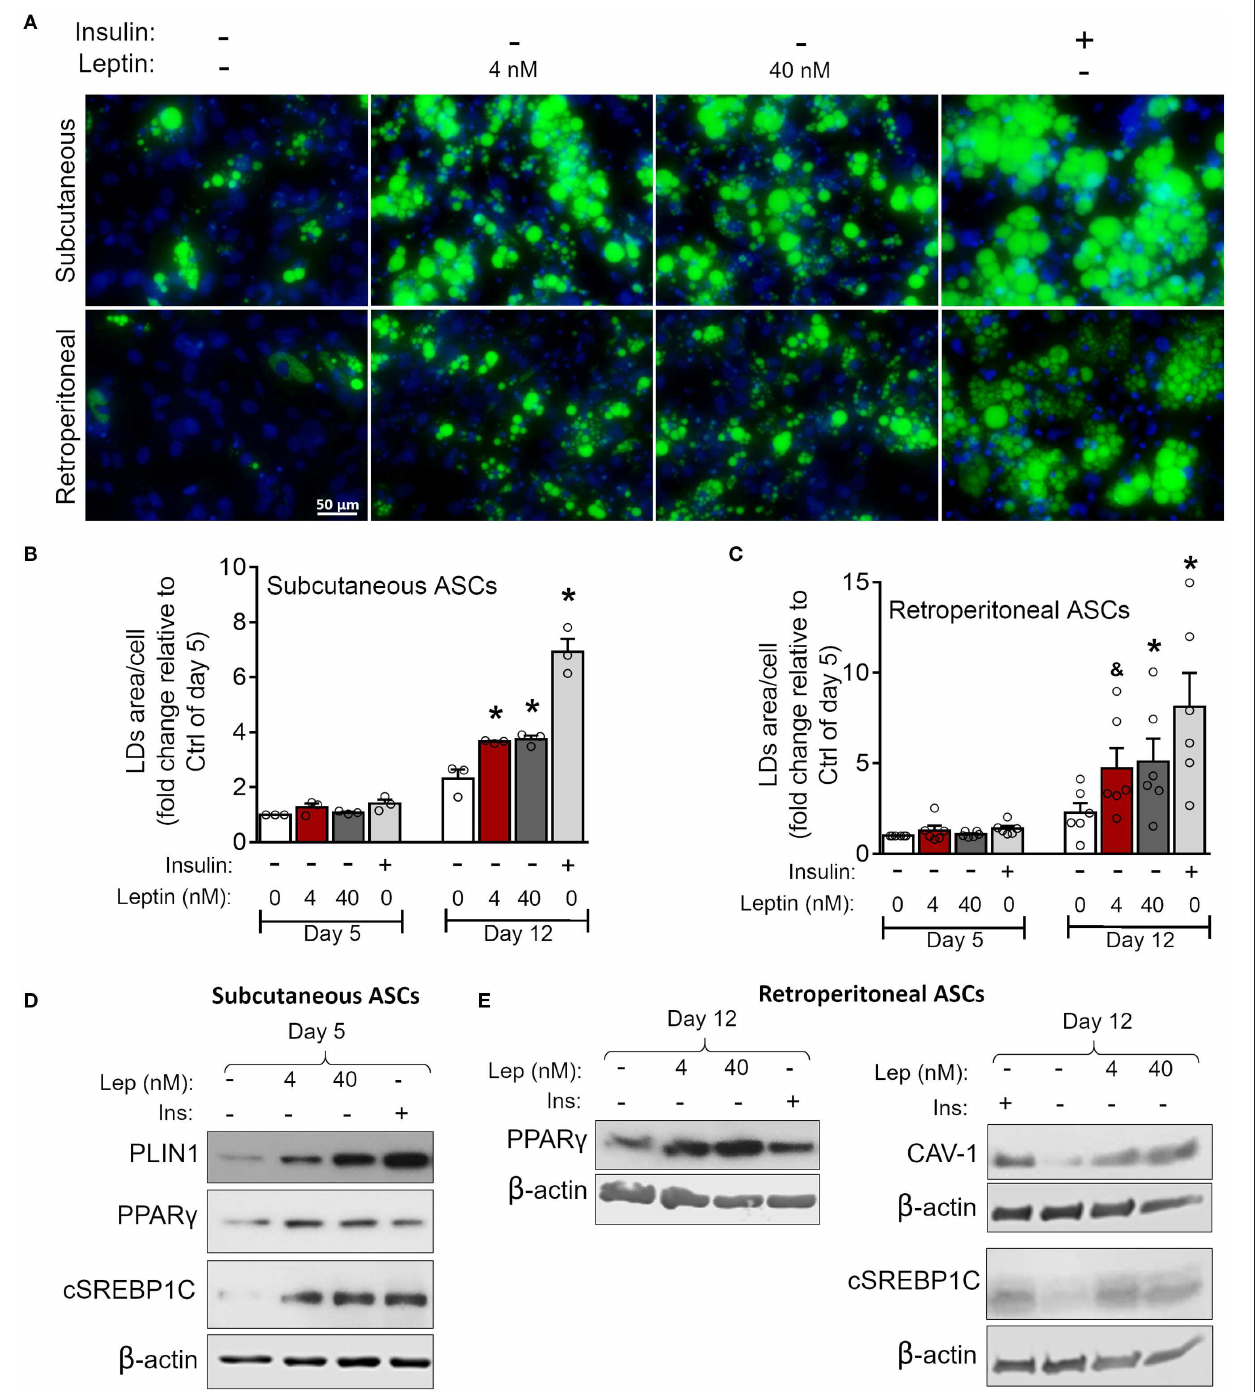
FIGURE 7 | Leptin induces adipogenesis in ASCs independently on insulin. ASCs from subcutaneous and retroperitoneal depots were isolated and then differentiated up to 5 or 12 days with neither insulin nor leptin, leptin (4 or 40nM), or insulin. (A) Fluorescence images of ASCs differentiated for 12 days and stained with Bodipy (green) for lipid droplets and with DAPI (blue) for nuclei. Images are representative of 3–6 independent experiments from different animal pools. Scale bar represents 50 µ m. (B,C) Quantification of the green area per cell in adipocytes differentiated from (B) subcutaneous or (C) retroperitoneal ASCs. Graphs depict the fold change relative to the group with no hormone supplementation at day 5. Bars represent mean ± standard error of the mean of 3–5 independent experiments. *Means p < 0.05 and & means p = 0.06 relative to the control group at the same day. Statistical analyzes were performed by using One-way ANOVA with Dunnet’s post-test. (D) Western blot analysis of PLIN1, PPAR γ , cleaved SREBP1C (cSREBP1C), and β -actin in subcutaneous ASCs or (E) CAV-1, cSREBP1C, PPAR γ , and β -actin in retroperitoneal ASCs after 12 days of differentiation in each condition. Blots are representative of 3–5 independent experiments.